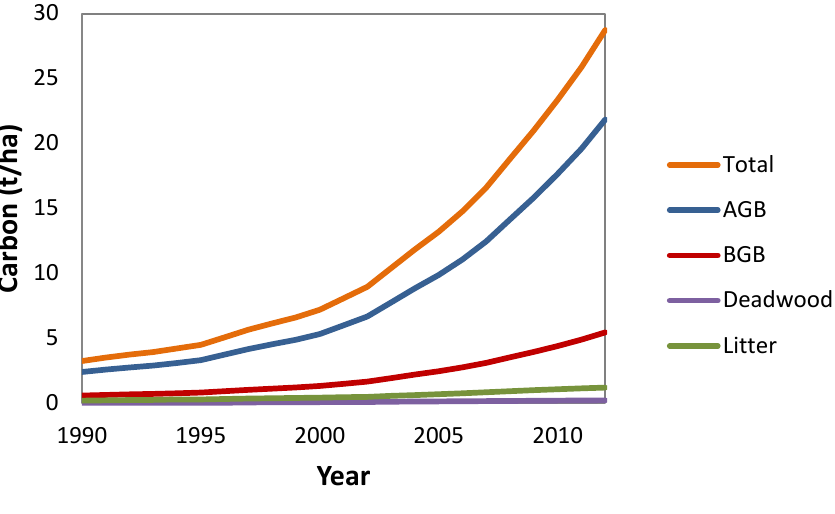
Figure 3. Average carbon stock in post-1989 forest annually (as of December) between 1990 and 2012 and by pool: AGB, BGB, deadwood and litter.